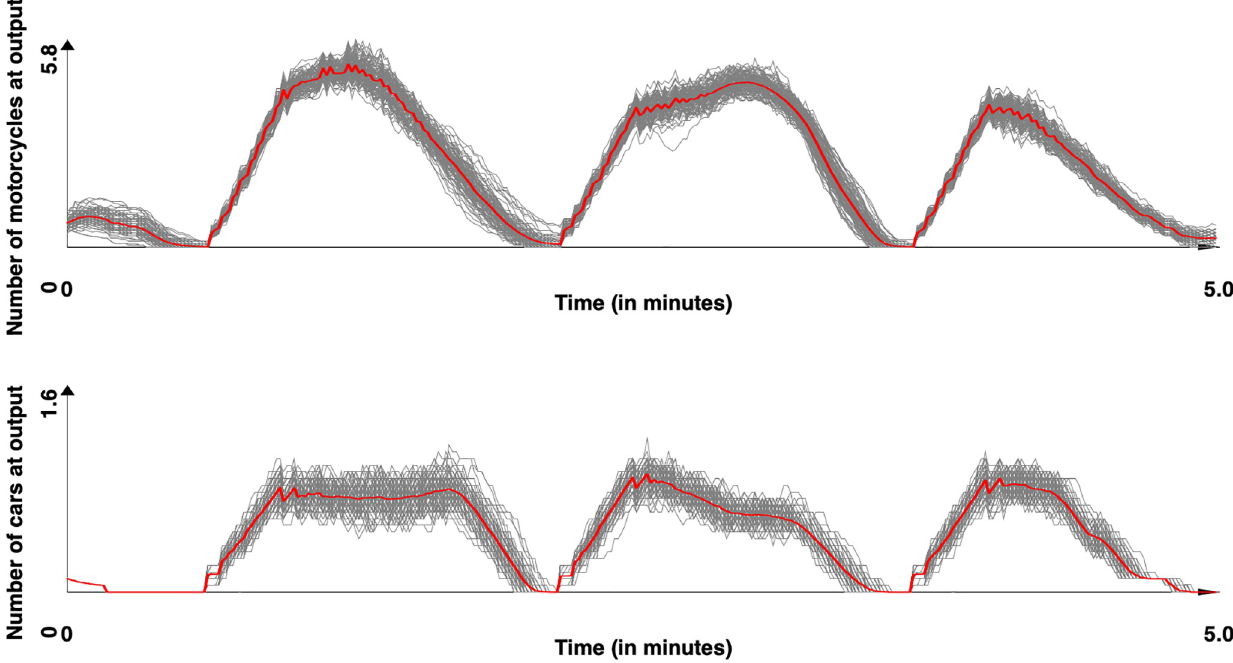
Fig 9. Simulated results for the Tay Son site. Motorcycle and car counts for the 100 simulations with our model (time series were smoothed out using moving average with a window size of 10s). In red, the mean values.